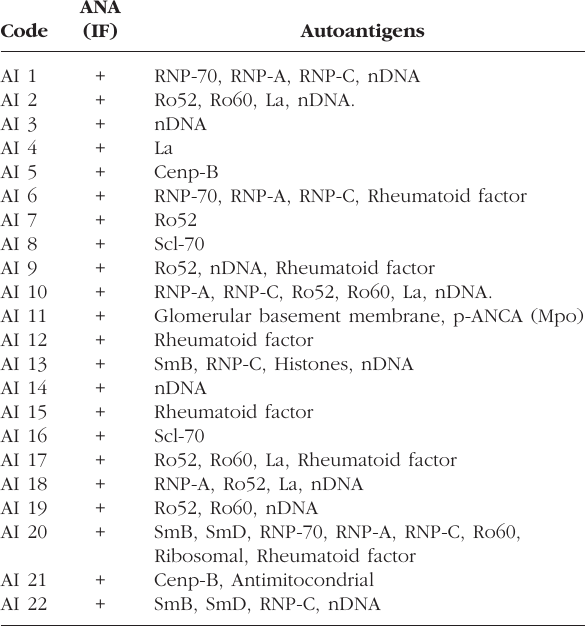
Table I. – Reactivity of the autoimmune sera against the nuclear and cytoplasmic antigens assessed in the INNO-LIA ANA kit (Innoge- netics). These parameters are the classical signatures of a number of autoimmune